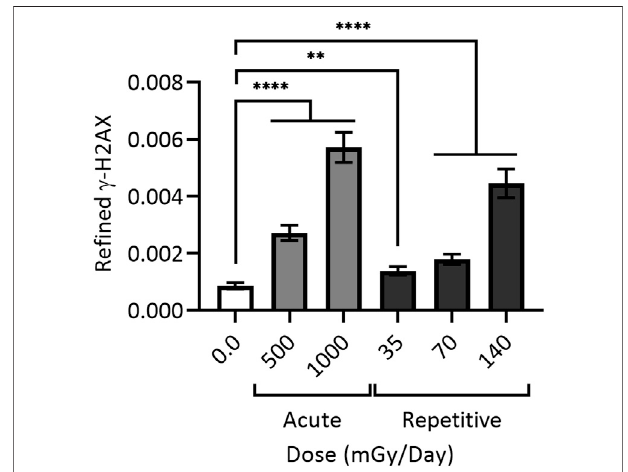
FIGURE 4 | Cumulative DNA damage observable with (daily) repetitive alphaparticleexposure evenatlowdoses( < 100 mGy). 48BRcellsweregiven a one-time (acute) dose of 500 or 1,000 mGy particle IR (light grey) or repetitively exposed to 35, 70 or 140 mGy particle IR once per day for 15 days(darkgrey),withshamirradiatedcontrol(white).Repetitivelyirradiated cells were harvested 24 h after the fi nal dose, whilst acutely irradiated cells were harvested 1 h post IR. All cells were then fi xed, stained and imaged together, generating re fi ned γ H2AX signal; black bars = mean ± SEM of n = 3 (1,700 cells total per condition). ** = statistically signi fi cant ( < 0.01); **** = statistically signi fi cant ( < 0.0001). Re fi ned γ -H2AX represents the average intensity of γ -H2AX objects per individual cell as a function of the size of the nucleus measured as DAPI volume, and corrected for signal expansion of γ - H2AX during DSB repair. For a more detailed explanation of re fi ned γ -H2AX, see (Stanley et al., 2020).